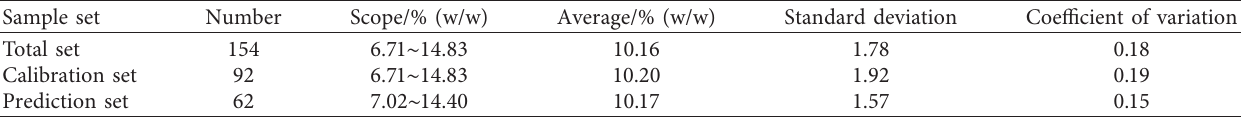
Table 1: Distribution of crude protein content in wheat flour of different sample